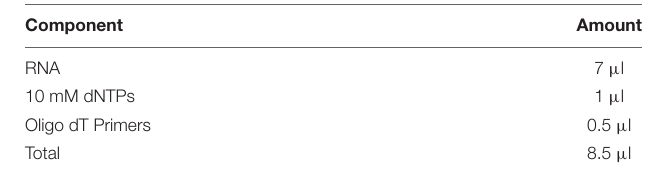
TABLE 7 | Reverse transcription reaction